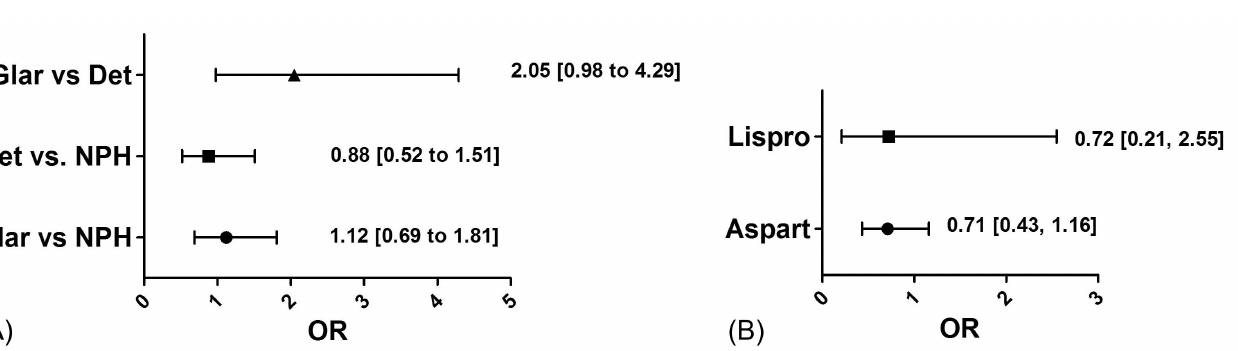
FIGURE 4 - Odds ratio for hypoglycemia (patients with any episode during the study) with insulin analogues, where A contains the meta-analysis of the safety of long-acting insulins and B contains the meta-analysis of the safety of short-acting insulin analogues. Legend: Glar, glargine; Det, Detemir; NPH, Human Insulin